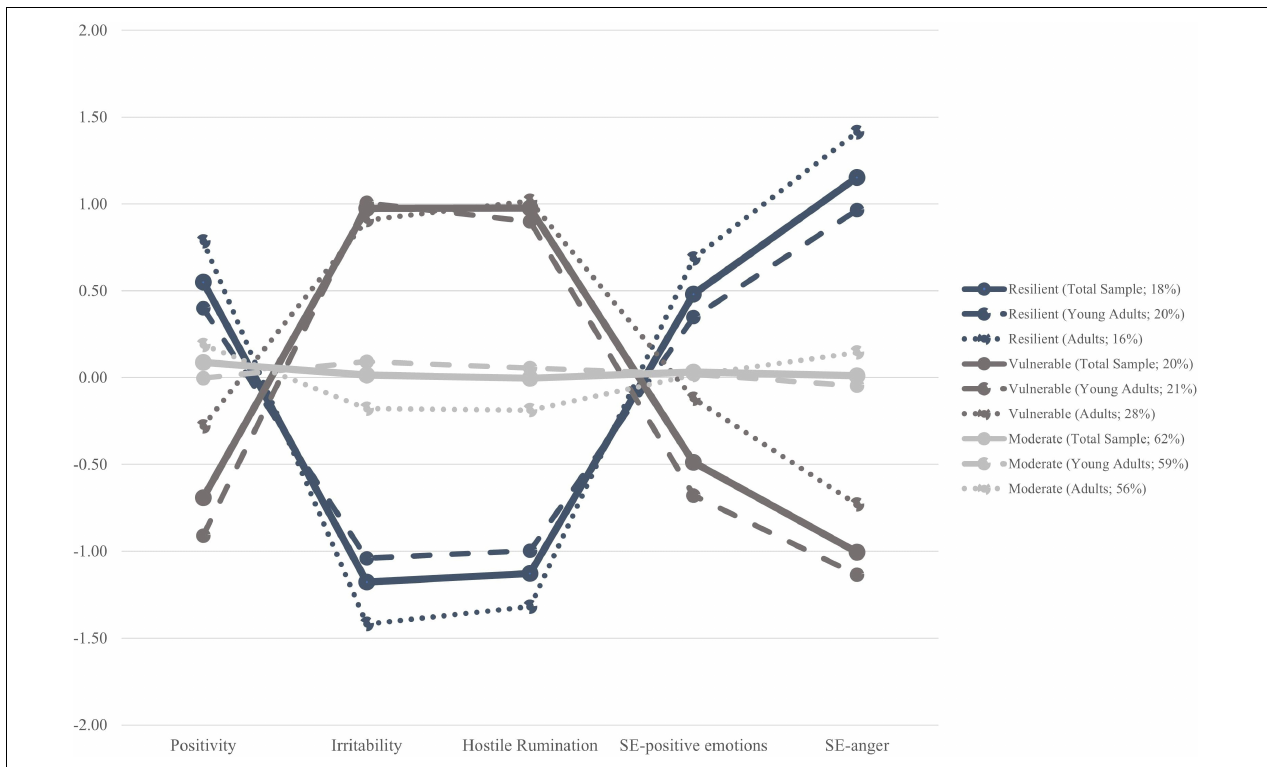
FIGURE 1 | Graphic interpretation of the three emerged personality profiles (i.e., Resilient, Vulnerable, and Moderate) in the total sample, young adults, and adults.